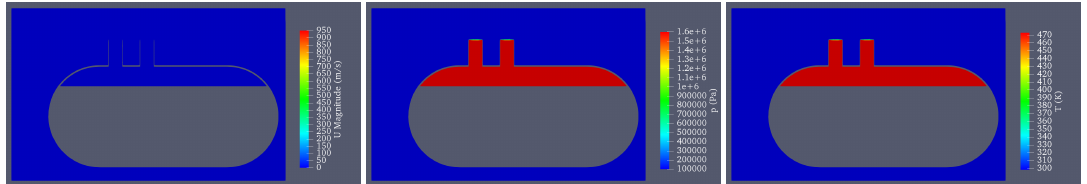
Figure 4. The distribution of velocity, pressure, and temperature in the initial state. In the space inside the PRT, the velocity is only 1 m/s in the z direction, the pressure is 1.6 MPa, and the temperature is 473 K (199.85 ◦ C), and in the outer space of the PRT, the velocity is 0 m/s, the pressure is 0.1 MPa, and the temperature is 298 K (24.85 ◦